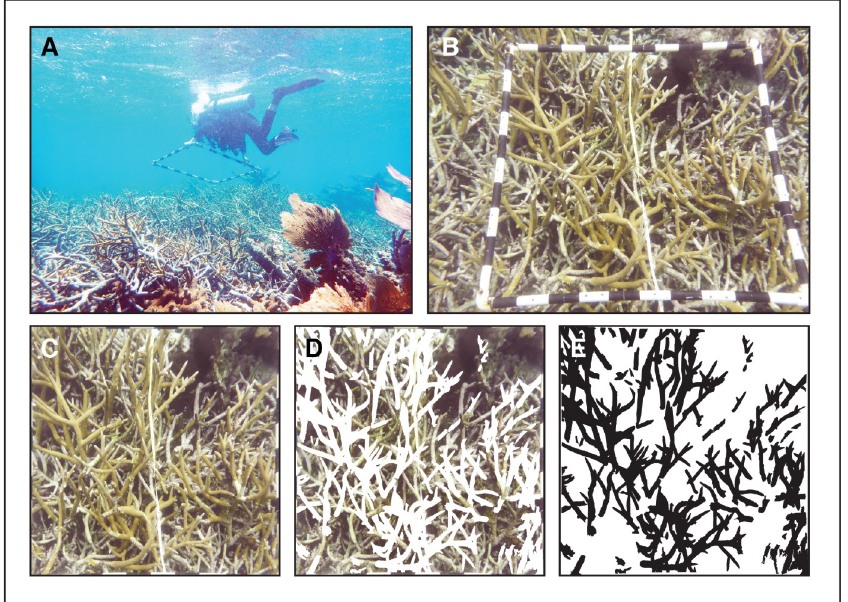
Fig 2. Live coral assessment methods. (A) Diver placing a 1 m 2 quadrat above reef acroporids; (B) Raw image taken from above the quadrat; (C) Image rectified (cropped and stretched) using a MATLAB script; (D) Same image